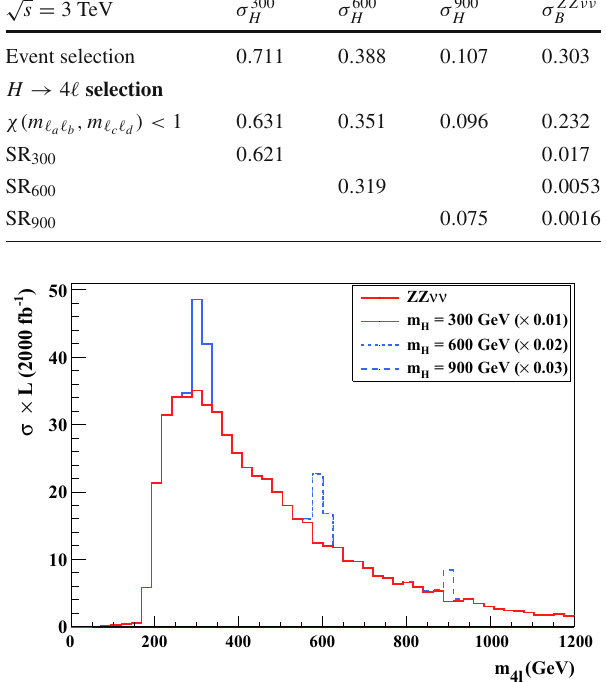
Fig. 3 m 4 (cid:2) distribution (with the vertical axis corresponding to the number of events for an integrated luminosity L = 2000fb − 1 ) for the signal e + e − → H νν ( H → Z Z → 4 (cid:2) ) with m H = 300 GeV (solid blue), 600 GeV (dotted blue), 900 GeV (dashed blue) and the dominant SM background e + e − → Z Z νν ( Z Z → 4 (cid:2)) (red), for